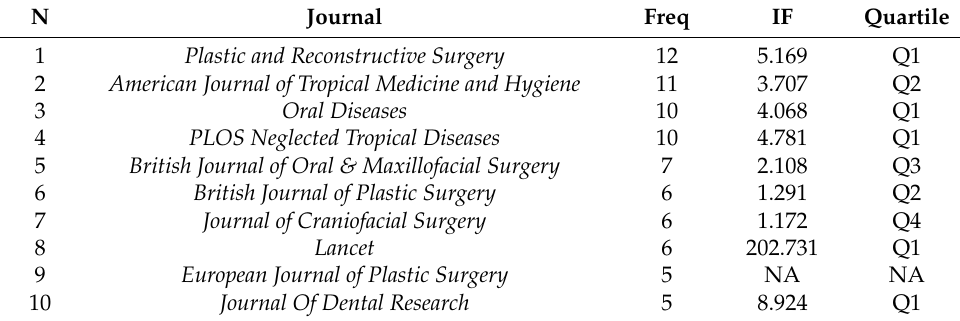
Table 2. Top 10 journals with the highest number of publications.